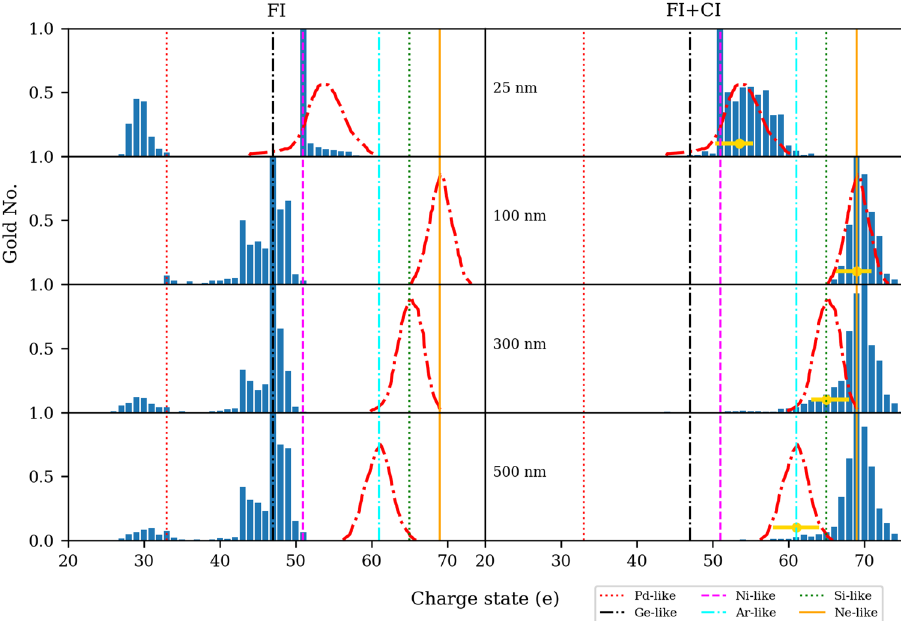
Figure 1. Simulation results of the charge state distributions of Au ions 2 ps after the interaction of a 4.1 × 10 20 W/cm 2 laser pulse with 0.5 ps pulse duration with different gold foils with FI (left) and FI + CI ◦ (right). Only Au ions with E (cid:31) 1 MeV/nucleon within a forward 10 half-angle from the target normal are considered. Red dash-dotted curves and horizontal golden lines show experimental charge state distributions and error bars, respectively, as seen in the experiment (Fig. 9 of Ref. 6 ). We can see a good agreement between simulations and experiments for thin targets, 25–100 nm. The only discrepancy is that for the 25 nm target, charge state 51 is much more populated in the simulation which is not seen in the experiment. For thick